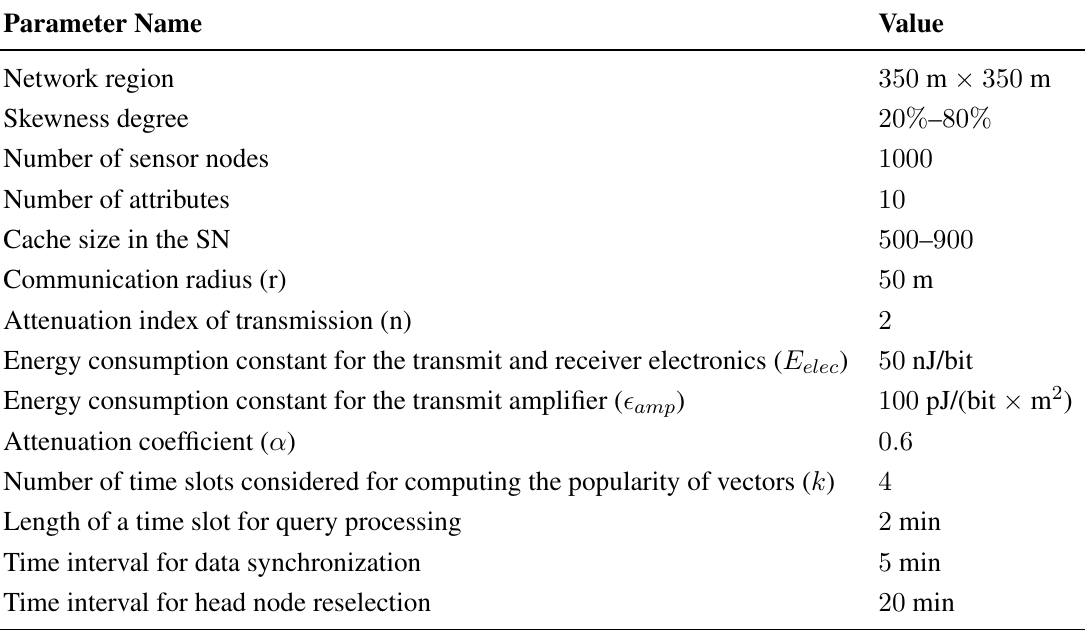
Table 5. Parameters settings in the